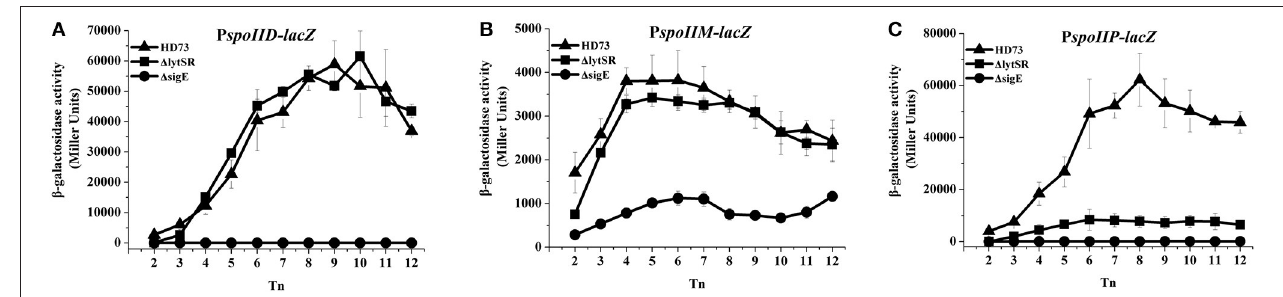
FIGURE 7 | Transcription of P spoIID , P spoIIM , and P spoIIP promoters in Bt . Transcription of P spoIID (A), P spoIIM (B) , and P spoIIP (C) in wild-type HD73 ( N ), lytSR mutant ( (cid:4) ), and sigE mutant (•) cells grown in SSM. T 0 is the end of the exponential phase, and T n is n hours after T 0 . Values represent the means of at least three independent replicates; error bars represent standard